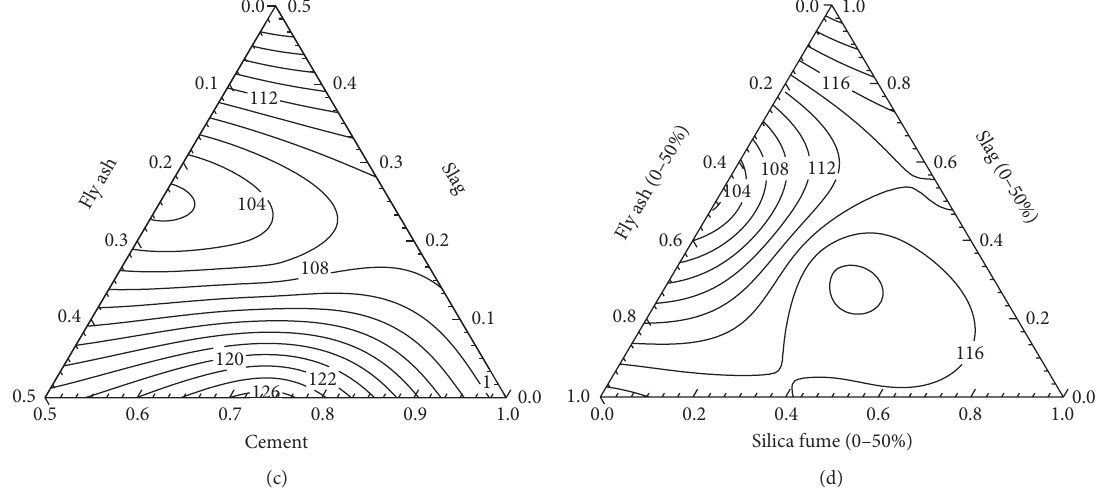
Figure 7: Compressive strength of UHPC (28d) with cementitious system of cement-silica fume-slag-fly ash